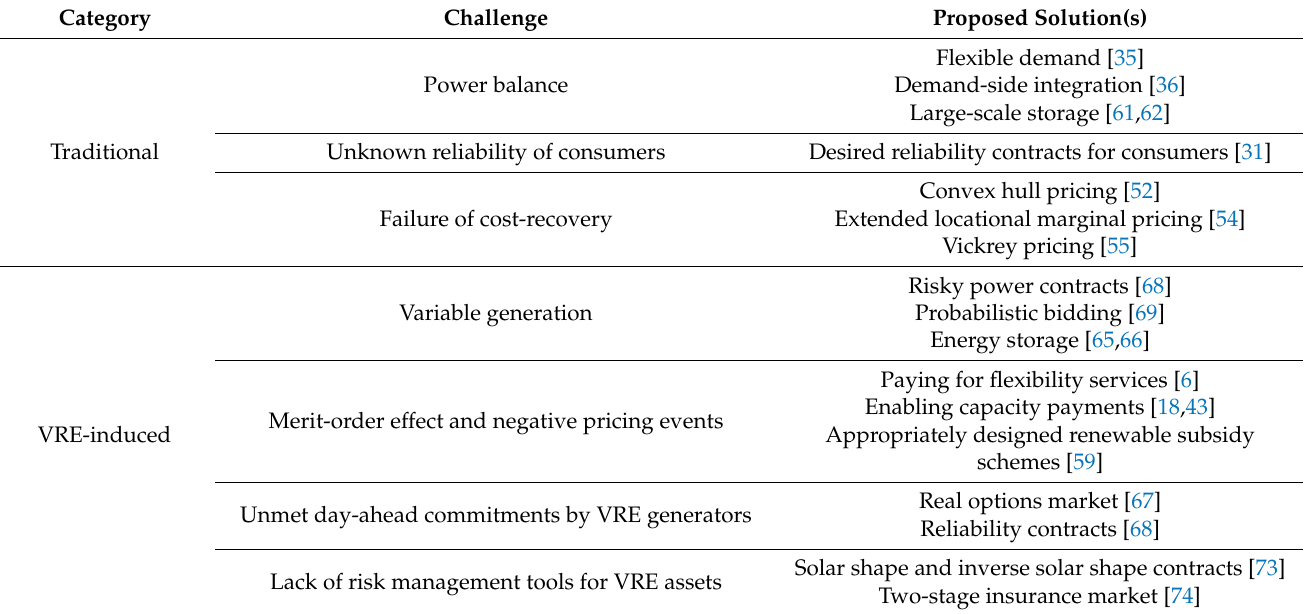
Table 2. Summary of market challenges and proposed solutions in the literature.